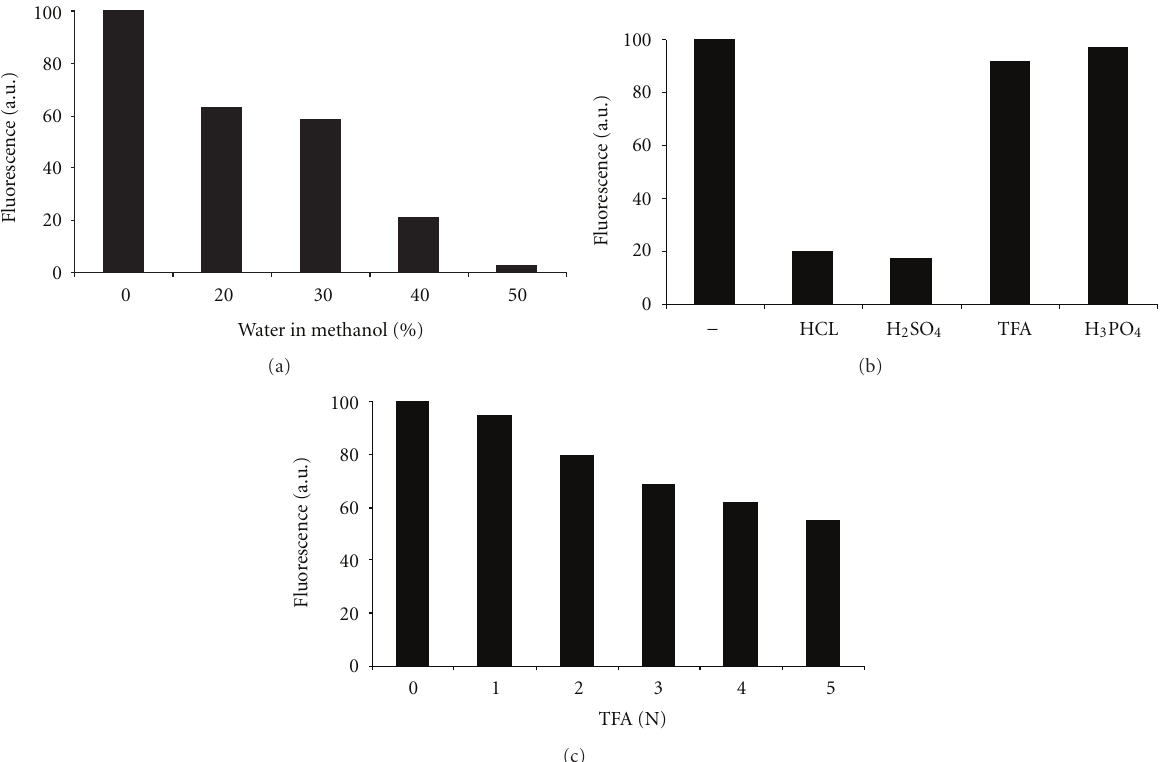
Figure 2: Influence of water and acidity on fluorescence of NBD-derivatives. Fluorescence of methanolic NBD-C 6 -Cer-1-P solutions (1 μ M, 200 μ L) containing increasing amounts of water (a) di ff erent acids at 0.5N final concentration (b) or increasing TFA concentration (c) ( λ ex 465nm, λ em 535 nm; Tecan Infinite